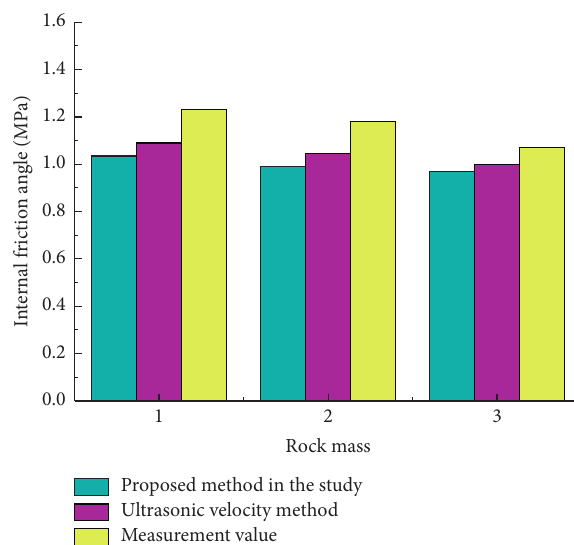
Figure 12: Comparison of the mechanical parameters of the rock mass from two methods and test values in the Ronglai hydropower